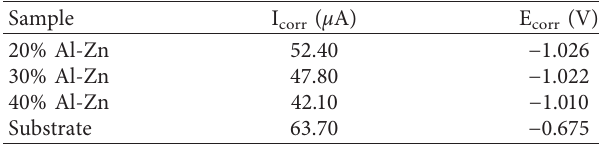
Figure 12: Polarization curves of three coatings in 3.5% NaCl solution. Table 3: Fitting results of several polarization